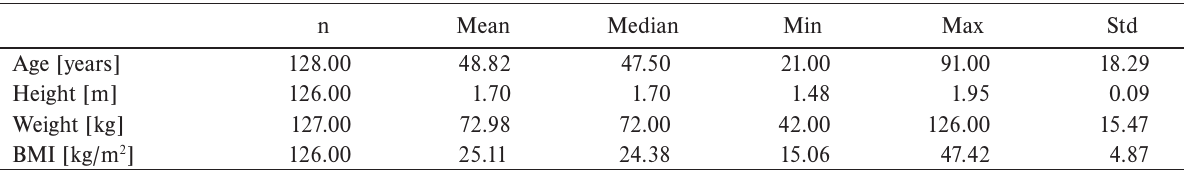
Table 1. Basic characteristics of the study population.